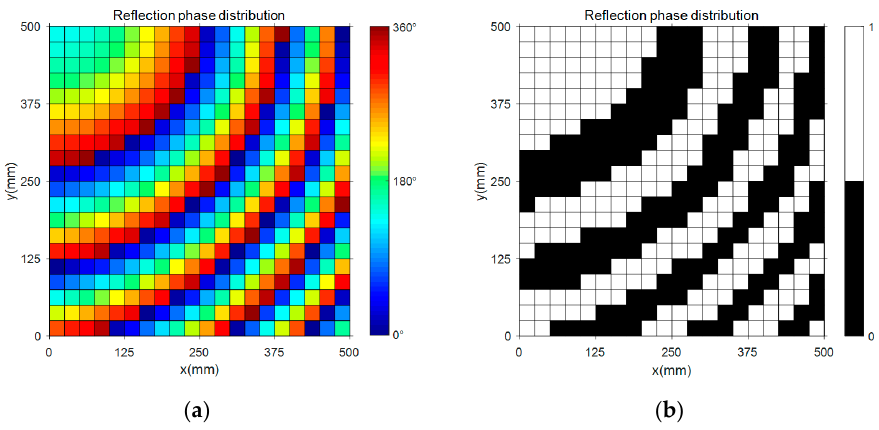
θ = ° ( a ) Accurate phase distribution; r